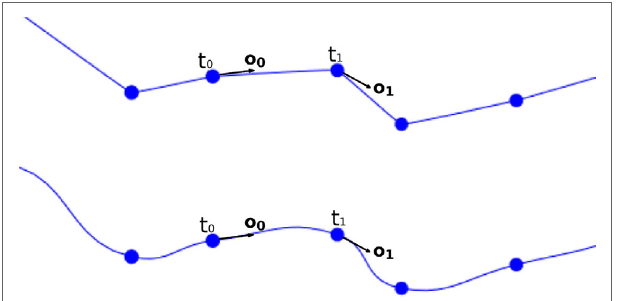
FIGURe 10 | Based on the information associated with the four vertices of the lateral quad and the two corresponding morphological tracing points, the center, c , the normal, n, and the displacement, r , are calculated to obtain the position of the new vertex, v.